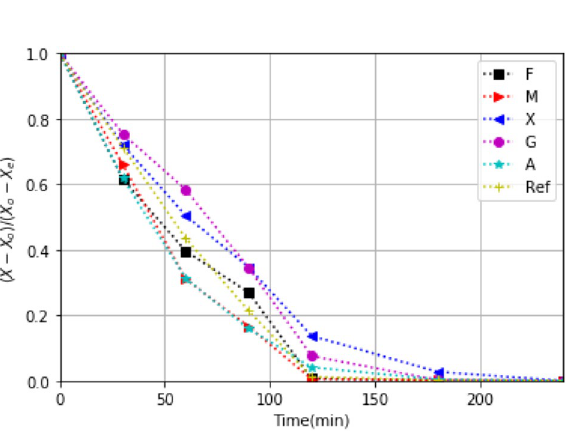
Figure 7. Drying kinetics for coated and uncoated (Ref) strawberry slices (2 mm in thickness) recorded for ◦ drying in an oven set at 60 C.